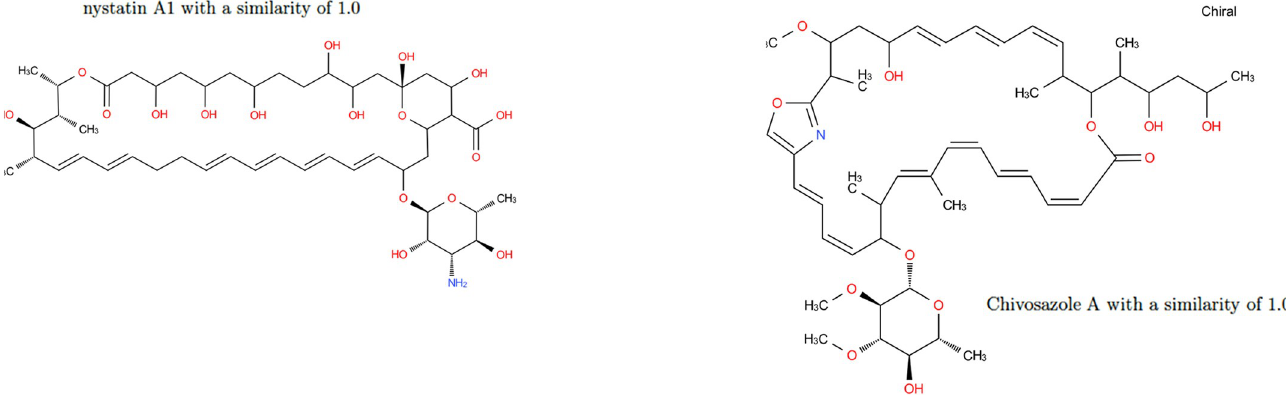
Fig 17. Results of similarity for Amphotericin B on GC. Nystatin A1 (ChEBI id 473992) and Chivosazole A (ChEBI id 80057) with a similarity of 1.0.